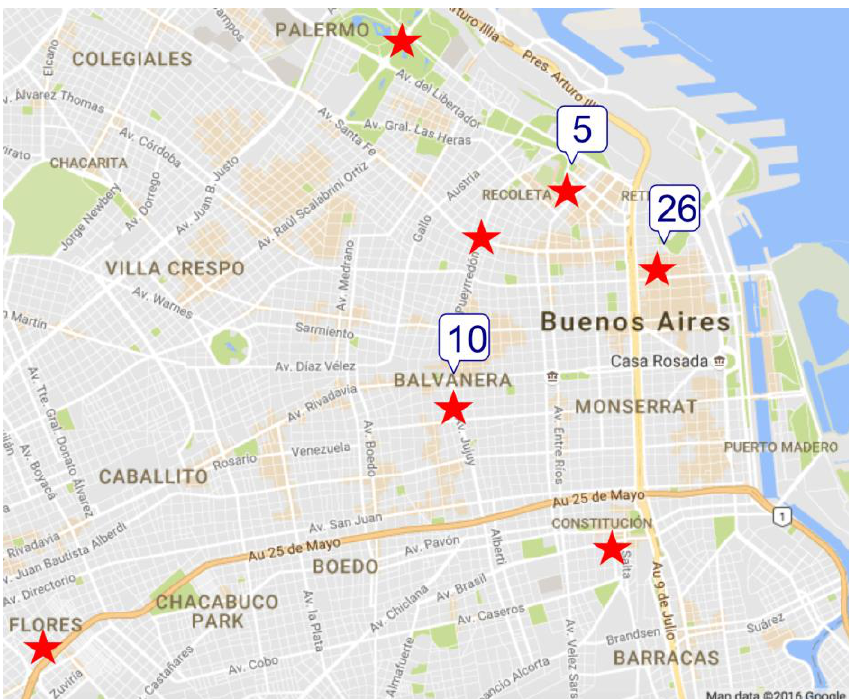
Figure 1. Interview locations in Buenos Aires. Red stars indicate approximate areas interview participants identified as places where sex workers concentrate. Numbers indicate number of sex workers interviewed in the area. Map from Google Maps . Table 1. Sex worker participant spaces of solicitation in Buenos Aires, Argentina by gender. Space of Solicitation (Neighborhood) Female Transgender